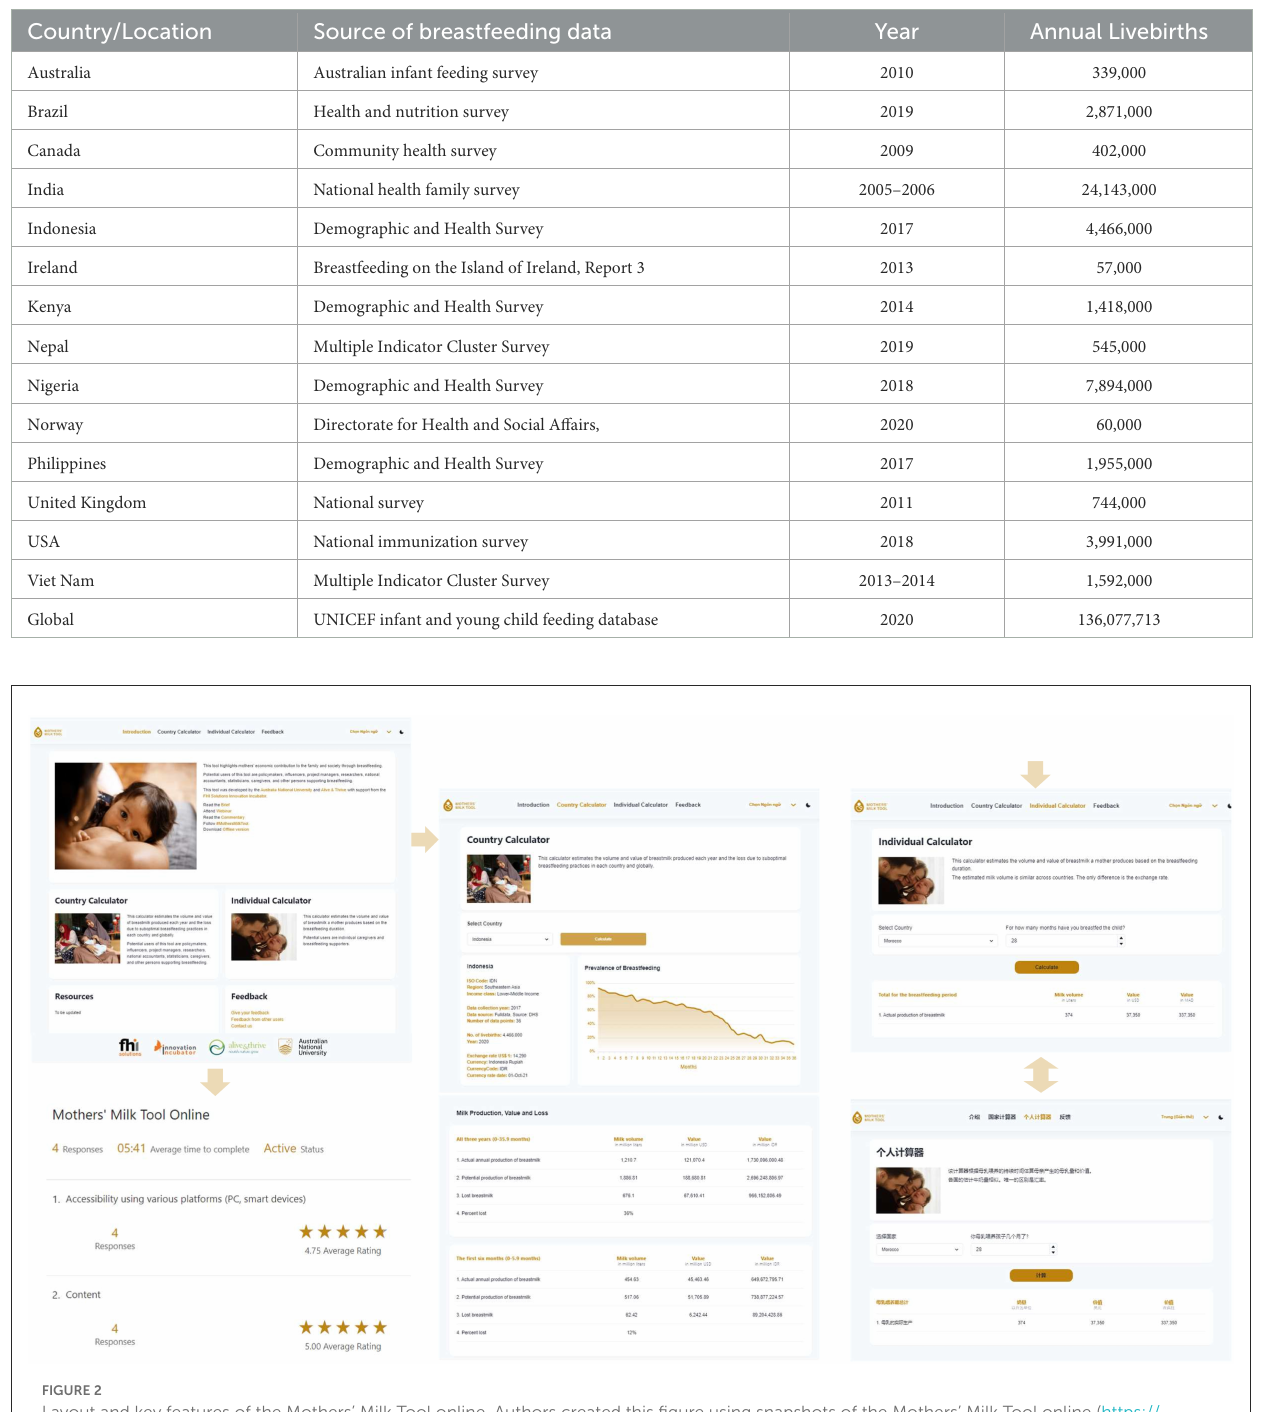
TABLE 3 Source of breastfeeding data.